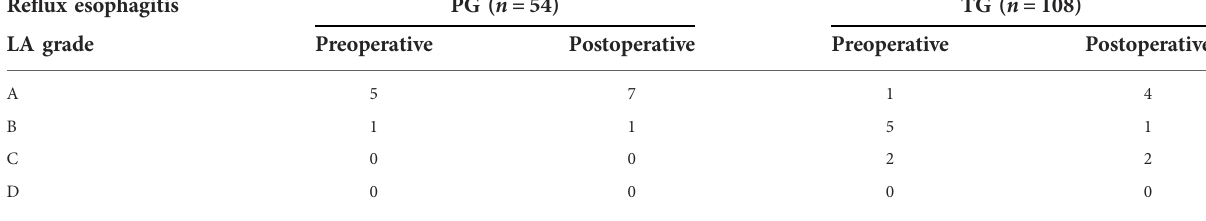
TABLE 7 Endoscopic fi ndings at 1 year after surgery. Re fl ux